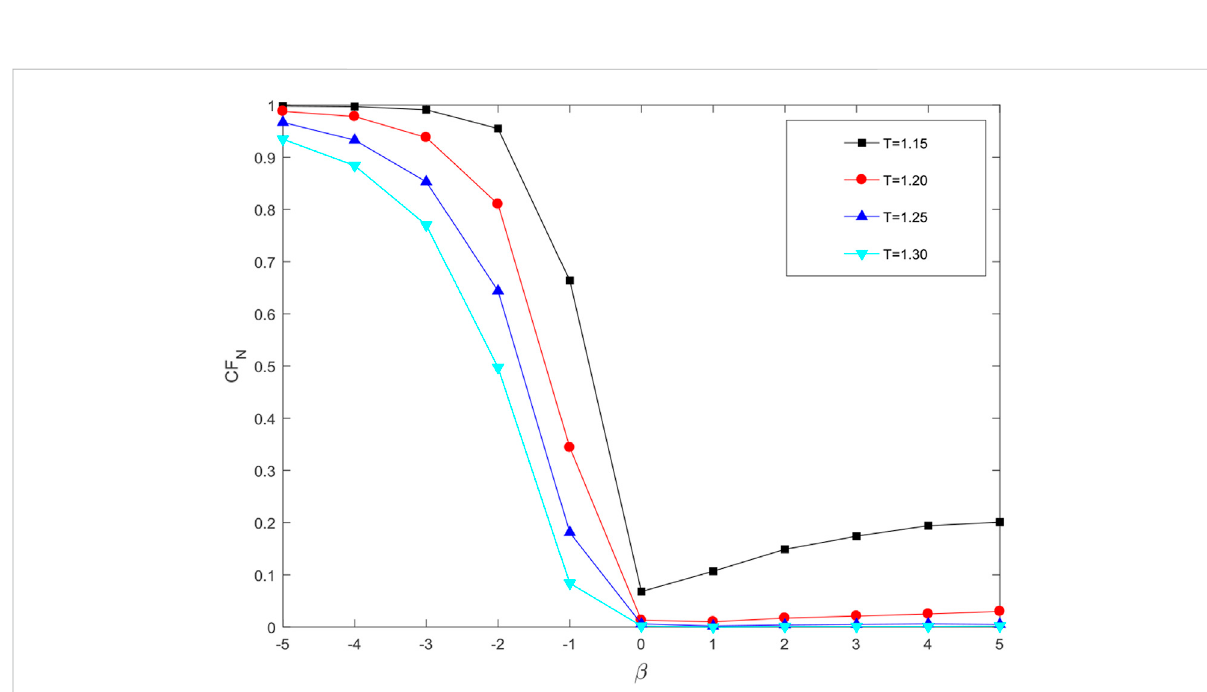
FIGURE 4 Effect of parameter β on the cascading failures performance. α (cid:1) 1 in the